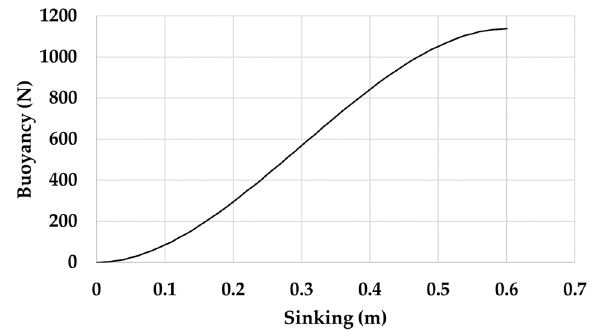
Figure 5. Buoyancy-sinking curve for the spar buoy.